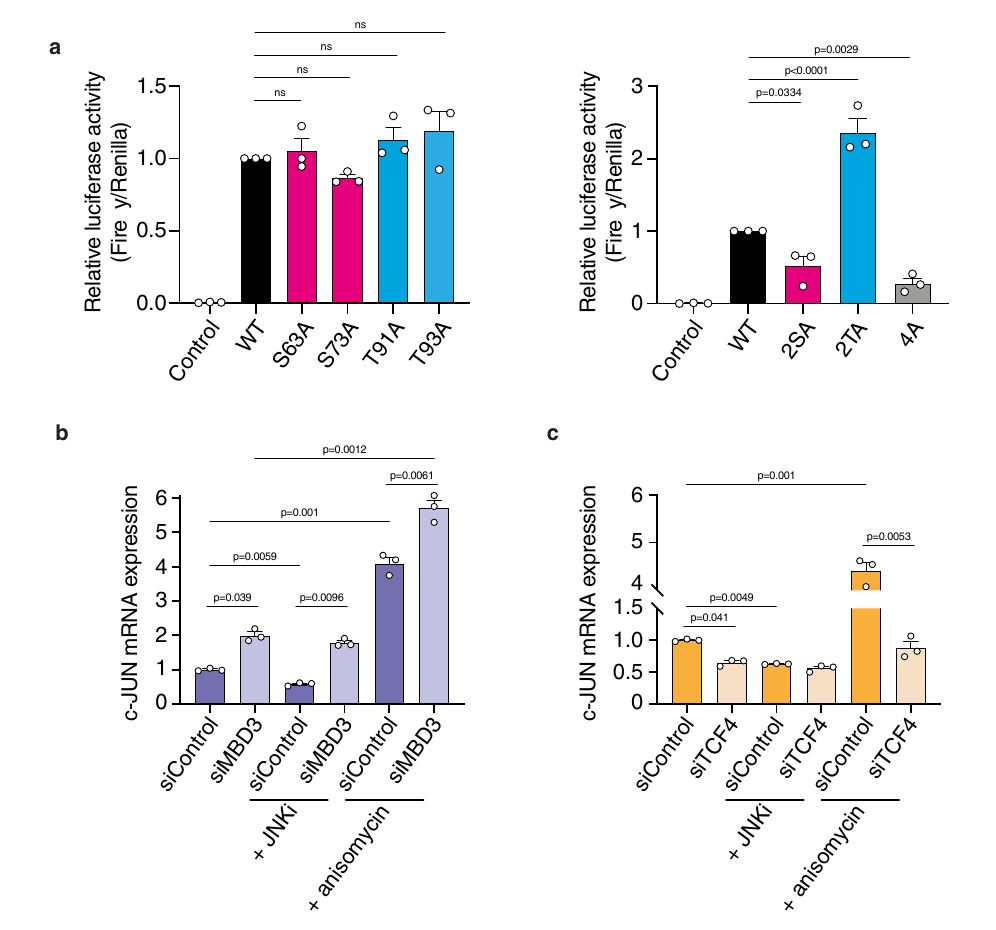
Fig. 5 | Effect of c-JUN phosphorylation on transcriptional activity. a NIH3T3 cells were transiently transfected to express: empty vector as a control, or c-JUN WT or c-JUN alanine mutants, fi re fl y luciferase reporter gene, tk-Renilla as trans- fection control, and constitutively active MEKK as an upstream activator of c-JUN phosphorylation.Fire fl yluciferaseactivitywasmeasuredandnormalizedtoRenilla luciferase activity and shown relative to c-JUN WT. Data are shown as the mean± standard error of the mean (SEM). Statistical signi fi cance was determined by One- way ANOVA with Dunnett ’ s multiple comparisons test ( n =3 biologically